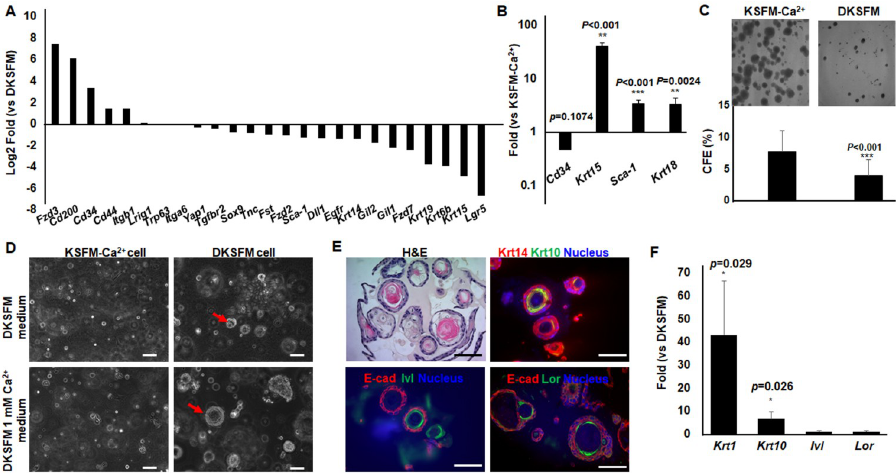
Fig 7. Stem and differentiation characteristics of the KSFM-Ca 2+ and DKSFM cells. (A) RNA-seq revealed common and unique stemness gene expression signatures of KSFM-Ca 2+ and DKSFM cells. (B) The expression of selective stem genes, i.e. Cd34 , Sca-1 , Krt 15 , Krt18 , were validated by qPCR. (C) Photographs of colonies formed with KSFM-Ca 2+ and DKSFM cells and the numbers of colonies were counted and CFE calculated. (D) Organoids in 3D BME culture in different culture media were photographed under microscopy in brightfields. Arrows point at the representative organoids. The DKSFM cell-derived organoids grown in DKSFM media plus 1 mM Ca 2+ were (E) subjected to histological analyses with H&E staining and immunostaining using antibodies indicated, and (F) examined by qPCR for expression of keratinocyte terminal differentiation genes, i.e. Krt1 , Krt10 , Ivl , and Lor . The scale bars in microscope images correspond to 100 μ m. Statistical analyses were performed with Student’s t-test using data derived from at least triplicate biological samples.